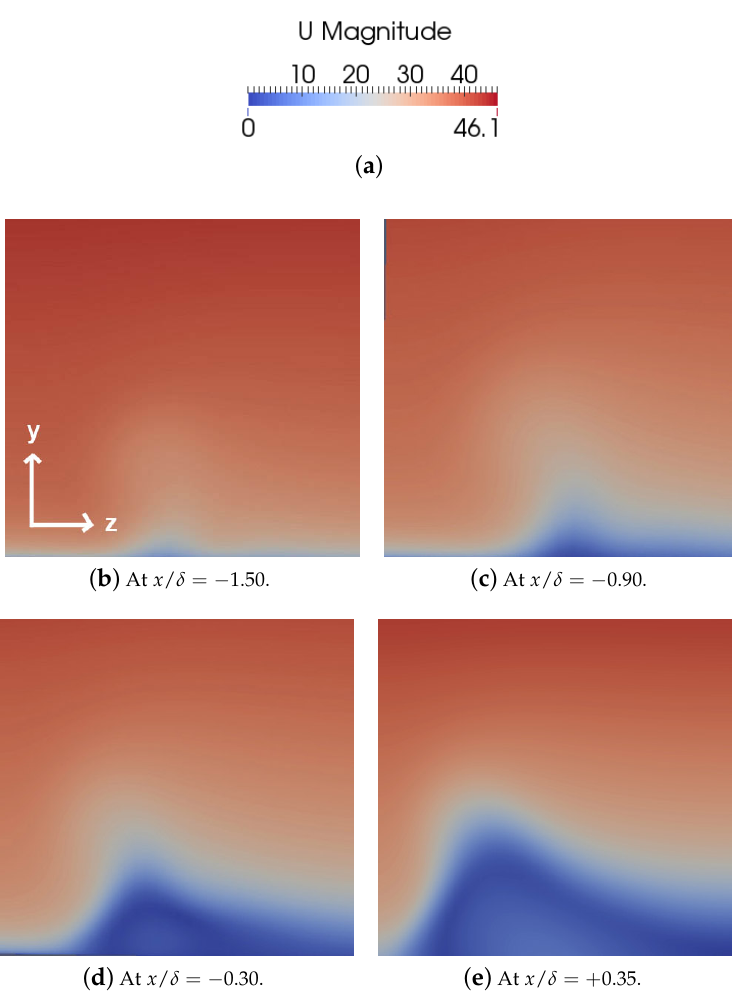
Figure 8. Velocity distribution (m · s − 1 ) at planes normal to the streamwise direction and located at distances x / δ from the backward-facing ramp. H 2 = 0.2 δ vane-type VG